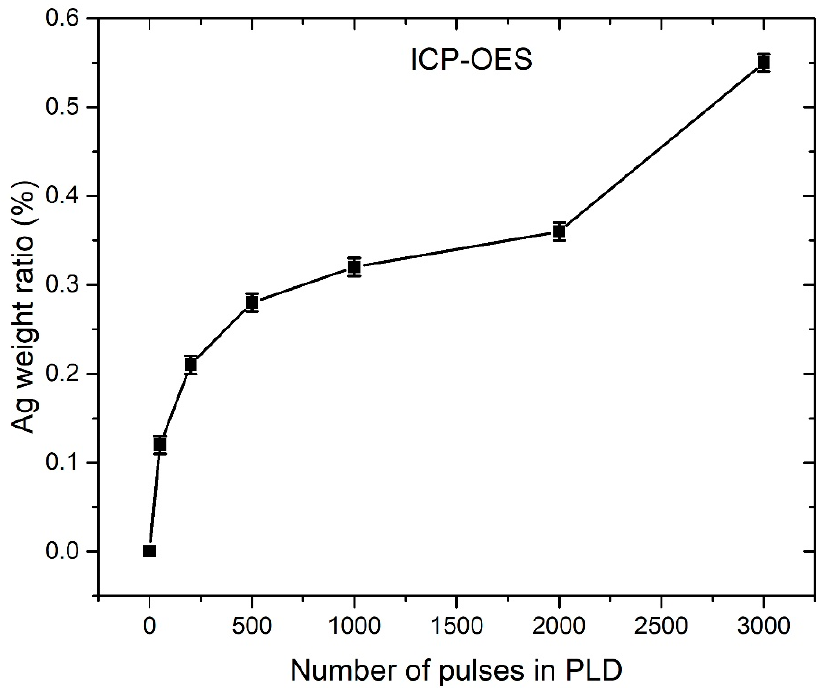
Figure 9. ICP-OES calculated Ag weight ratio in PLAL-synthesized Ag-doped ZnO NP that is dependent on number of pulses used for Ag deposition in PLD synthesis of PLAL target .